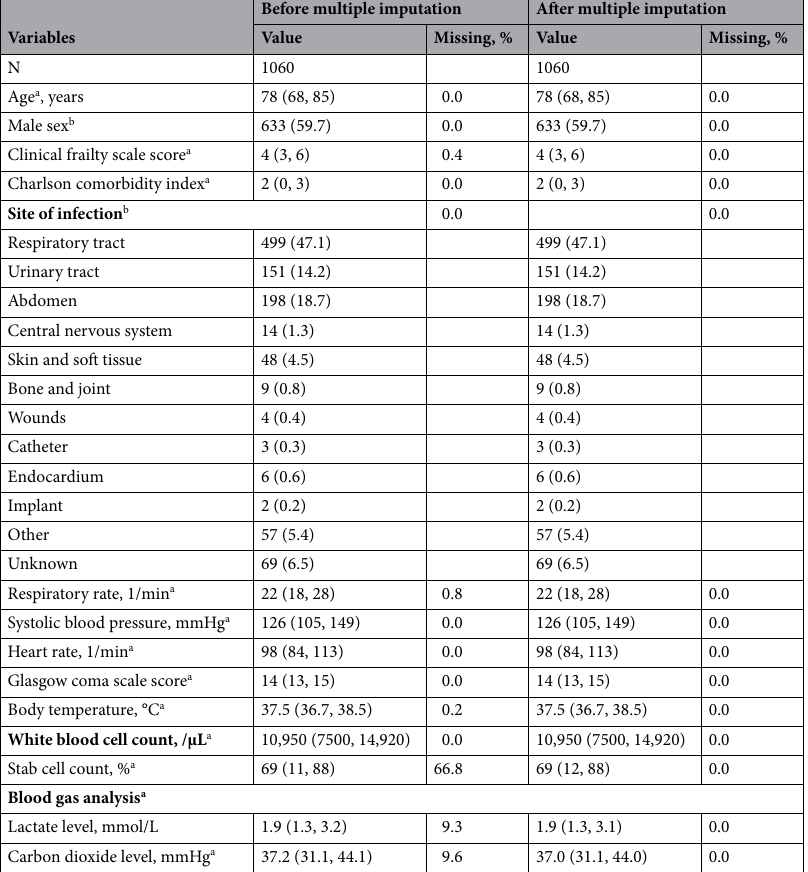
Table 1. Baseline characteristics of the cohort before and after multiple imputation. Data for all variables were obtained at the emergency department at the time when infection was suspected. a Numeric variables are reported as median and 25th–75th percentile after pooling the values across the multiply imputed datasets. b Nominal variables are displayed as number and percentages after averaging the counts across the multiply imputed datasets and rounding into